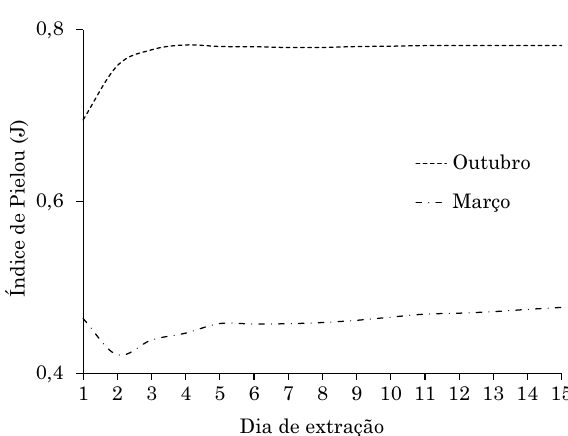
Figura 3. Variação diária do índice de Pielou (J), em razão da quantidade de organismos capturados, discriminada por época de avaliação: em outubro, um dia antes do plantio das leguminosas; e, em março, por ocasião do corte da parte aérea das plantas.